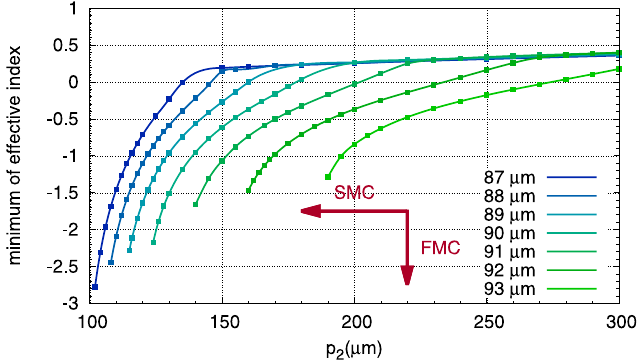
Fig. 10. Effect of both mode couplings ( spatial mode coupling (SMC) and frequency mode coupling (FMC)): minimal value of the effective refractive index n eff as a function of the distance p 2 between two resonators for several values of the side length a e of the electric resonator. The side length of the magnetic resonator is a m =60 m m. The two arrows denote increasing mode coupling. The minimum of the real part of the effective index is n eff